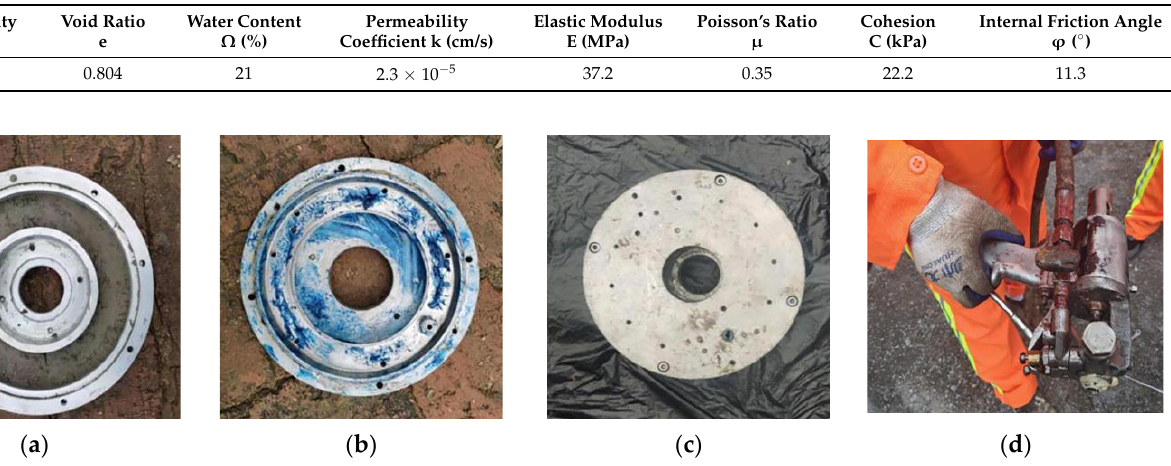
Figure 5. Polymer grouting process: ( a ) filling the soil sample in the core; ( b ) applying lubricating fluid to the ring; ( c ) fastening the connection between the core and the ring; ( d ) grouting into the mould.